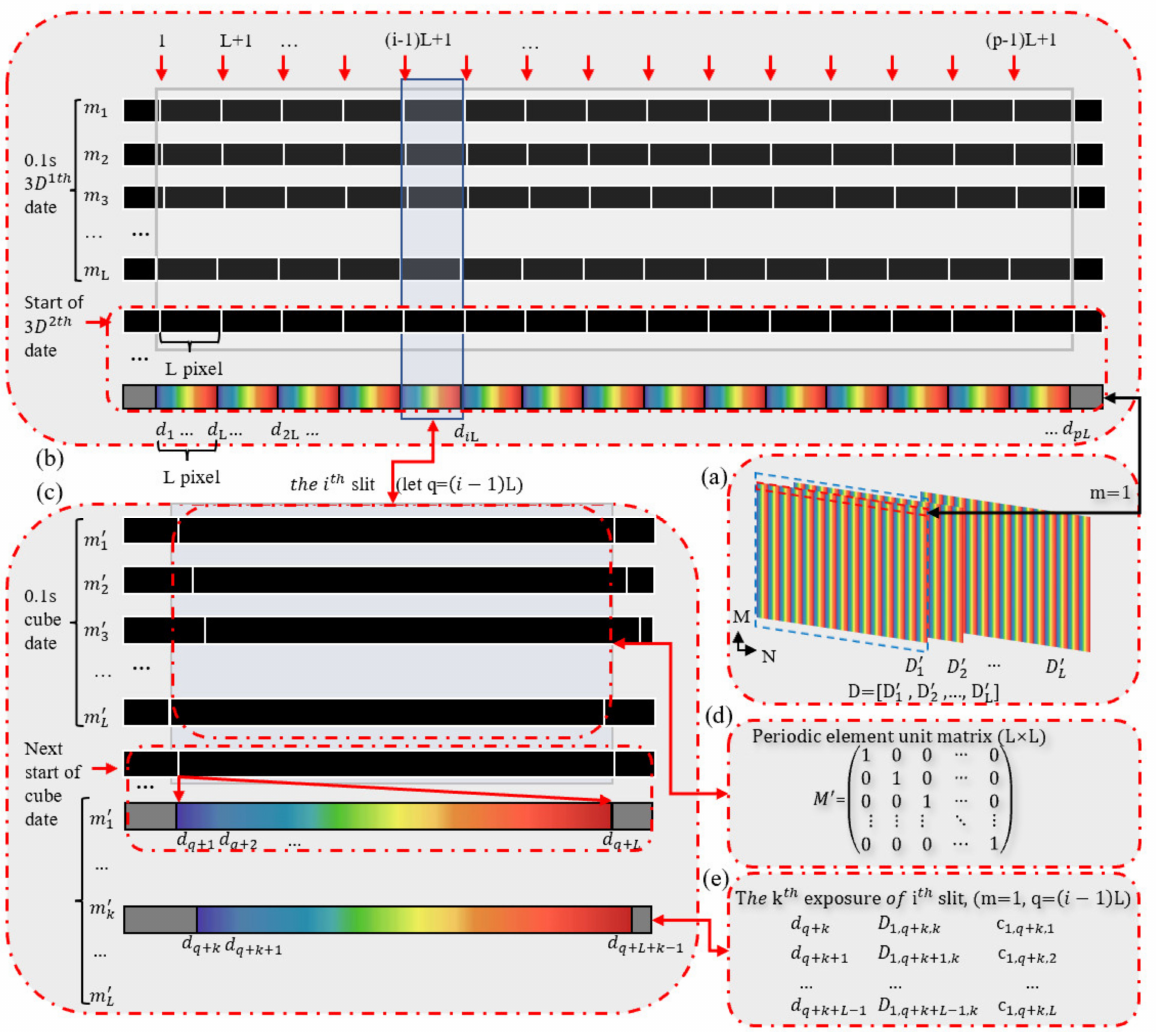
Figure 2. Data flow chart of the uniformly distributed-slit array coded spectral imaging system. ( a ) L times of a whole detector data acquisition during the movement of the uniformly distributed-slit array. ( b ) The L positions of the uniformly distributed-slit array corresponding to one period of detection. ( c ) The dispersion of the i th slit located in the aperture diaphragm. ( d ) A single slit moving within one sample period, taking the row distribution to obtain the full rank unit matrix M (cid:48) . ( e ) The dispersion of the i th slit at the k th exposure